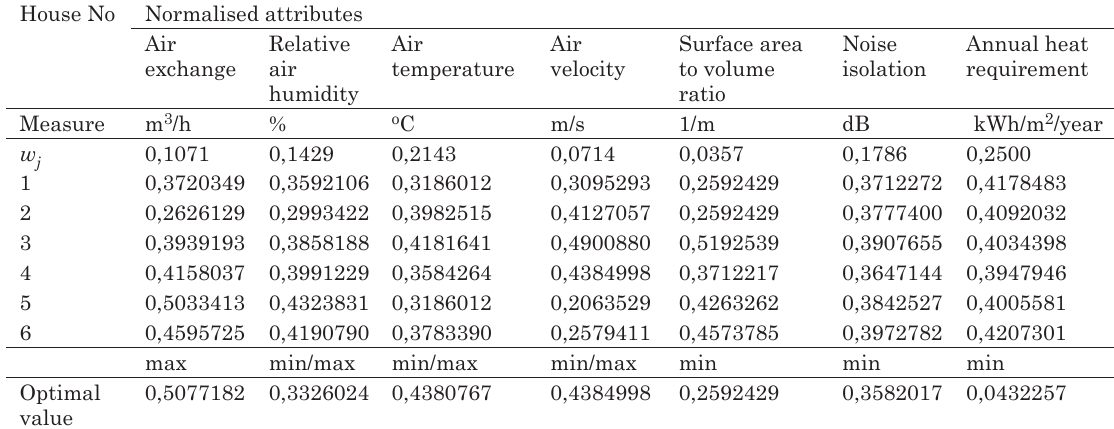
Table 4. normalised decision-making matrix of the 6 apartments in naujoji Vilnia, Vilnius House no normalised